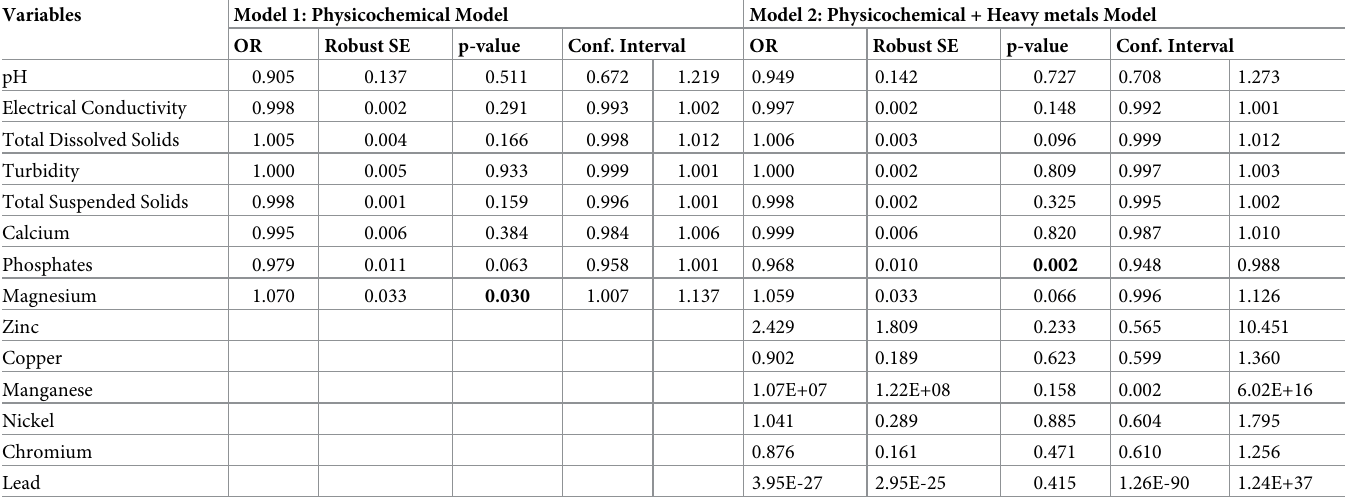
Table 7. Multivariate negative log–log regression model predicting detection of total coliform in surface water.